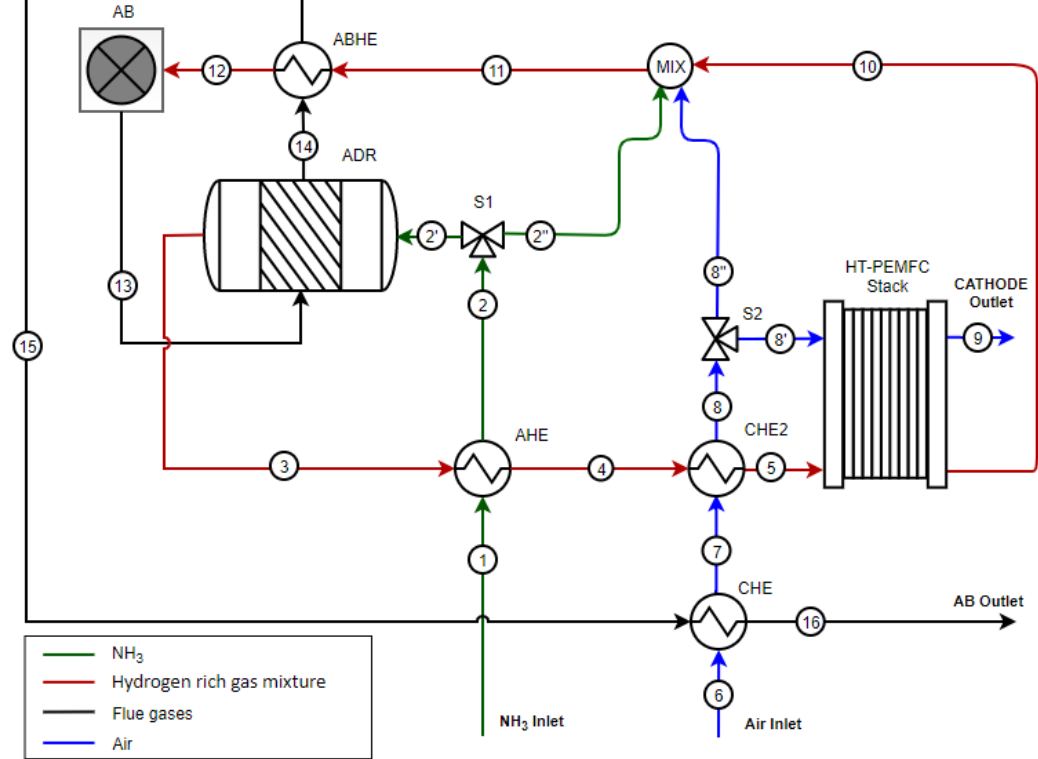
Figure 1. Conceptual schematic of the integrated ammonia decomposition reactor-HT-PEMFC system.